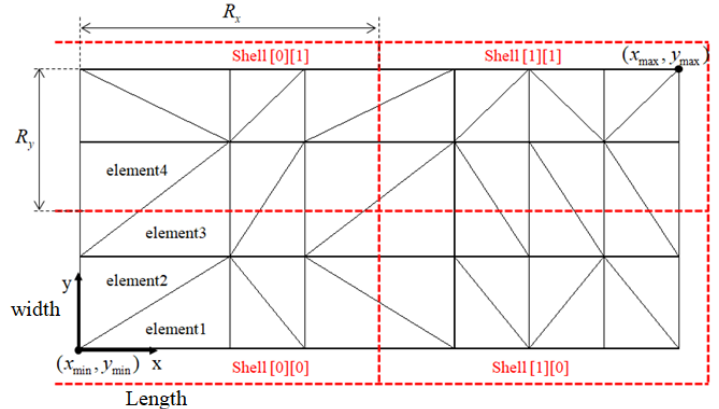
Figure 16. Shell concepts to efficiently contact search between 3D ground and track. The length and width of the 3D ground are defined by the x-y plane, and the height of the ground is defined by the z position. The length and width of the ground can be obtained as in Equations (38) and (39), respectively.